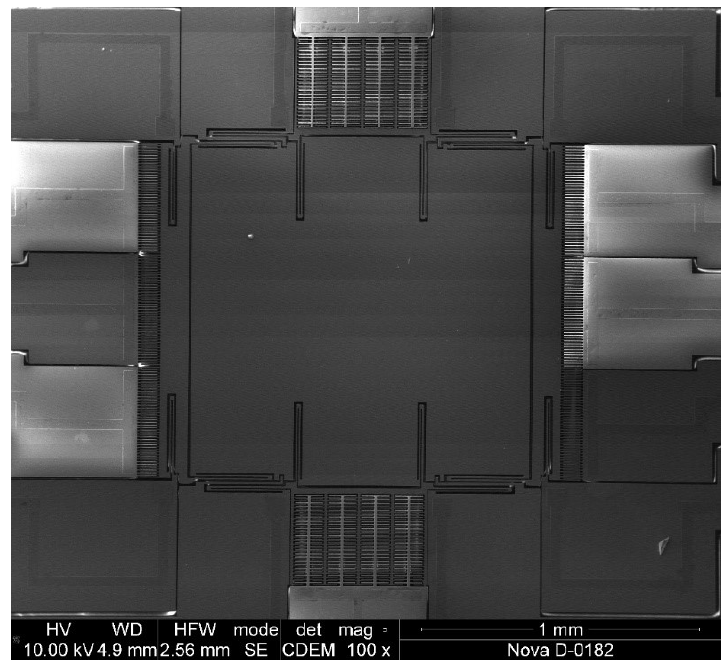
Figure 29. General view of the MEMS gyroscope sample under study using SEM. To measure the height of the structure and the amount of etching of the mask, as shown in Figure 30, several SEs had to be destroyed.